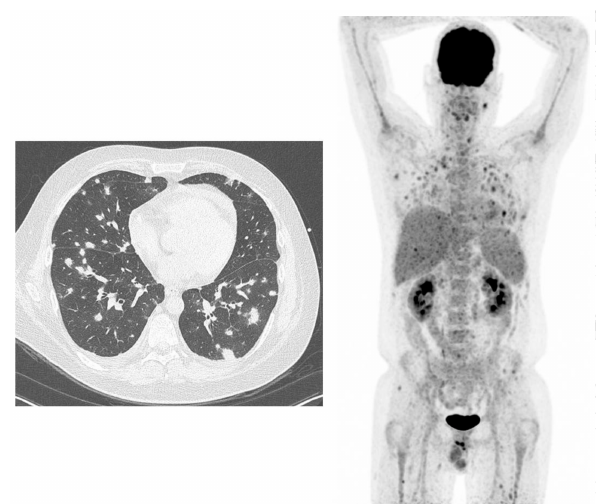
Figure 1. 38-year-old male, known with acute lymphatic leukaemia. Because of fever and bacteraemia he was treated with meropenem (antibiotics). High-resolution computed tomography (HR-CT) (left figure): several lung densities with irregular borders, not typical for bacterial infections, but typical for angio-invasive aspergillosis, because of the halo sign. 18 F-fluorodeoxyglucose positron emission tomography / computed tomography ( 18 F-FDG-PET) (right figure): not only lung involvement but also infectious lesions in the liver, spleen and in muscles throughout the body.